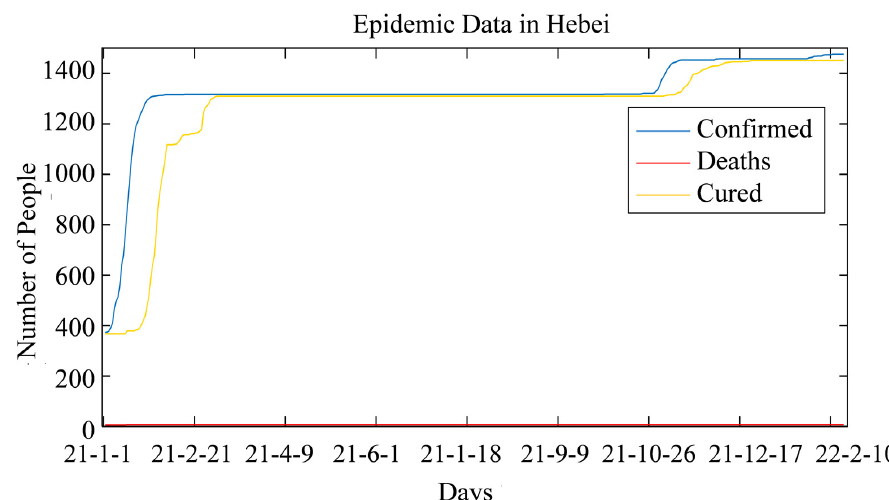
Figure 11. Relevant epidemic data of Hebei city.